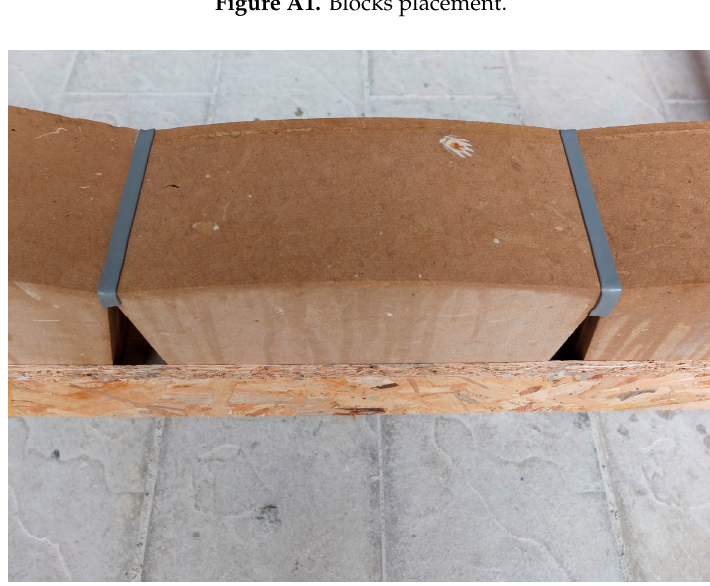
Figure A1. Blocks placement.